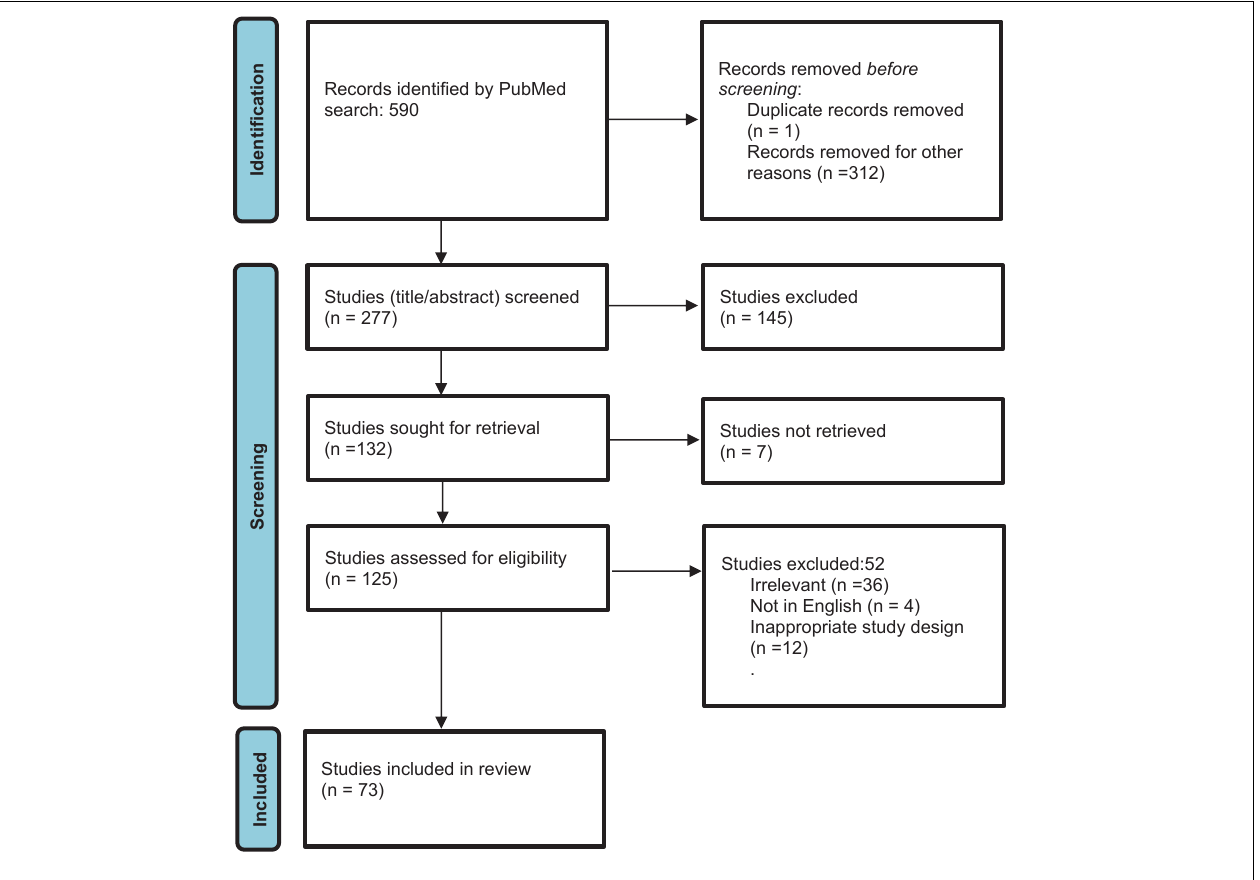
FIGURE 2 | PRISMA Flow diagram of included